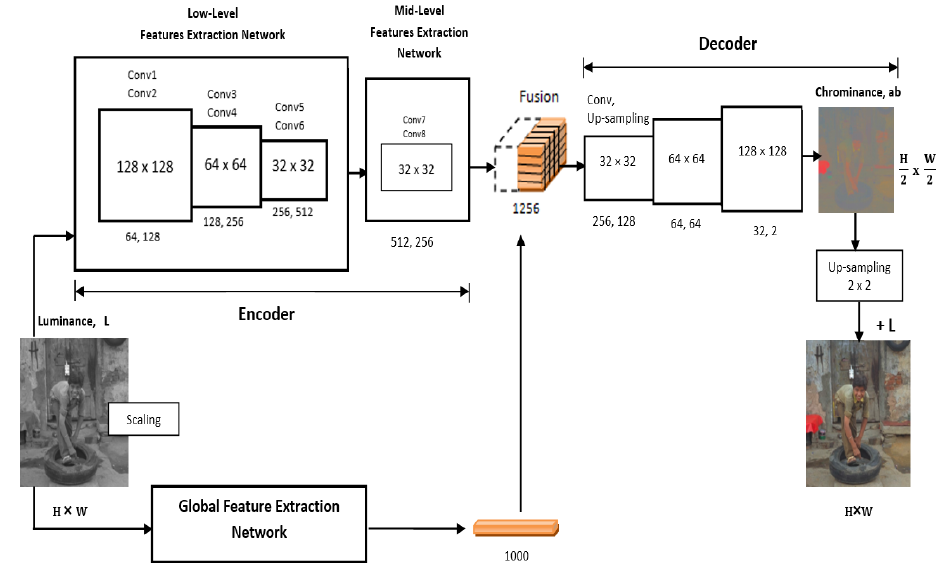
Figure 4. Overview of the model architecture for automatic colorization of black and white